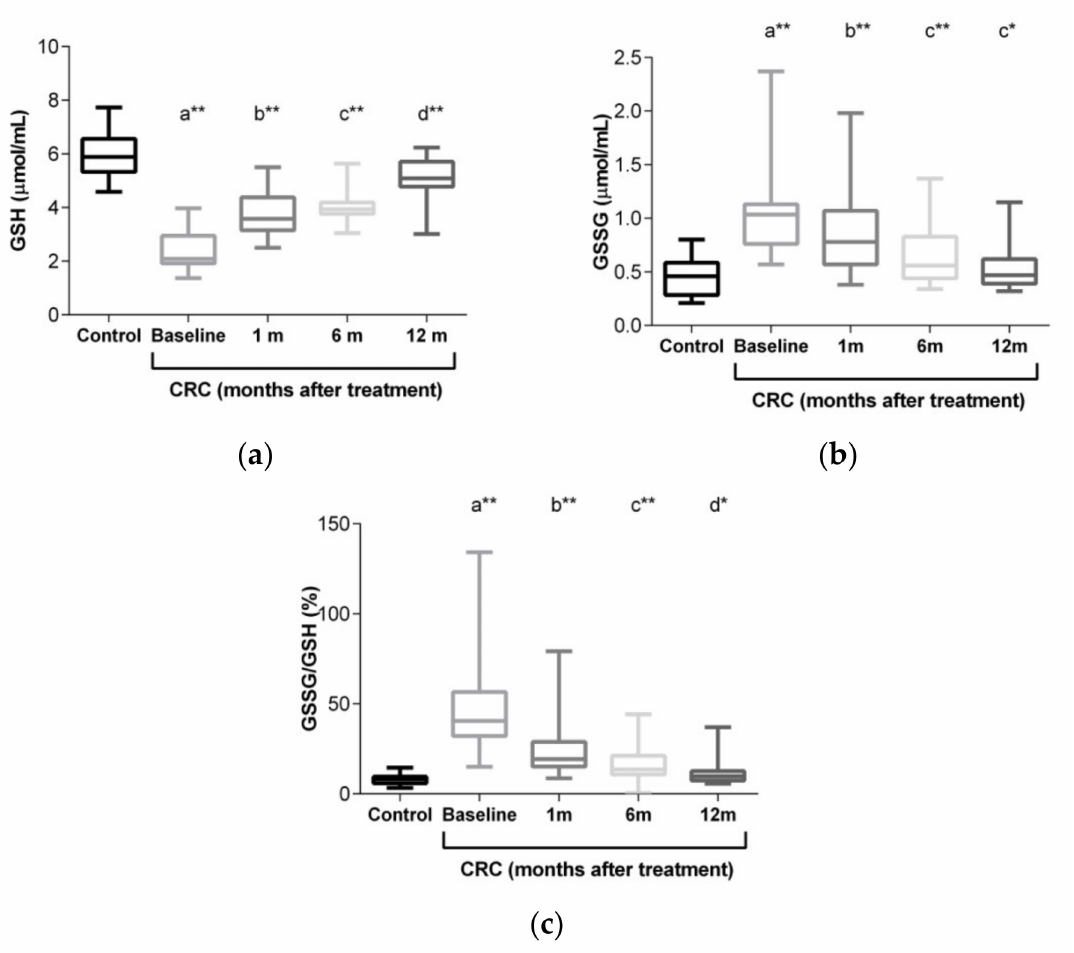
Figure 4. Time course evolution of serum glutathione levels after treatment of colorectal cancer (CRC) patients and controls. ( a ) Reduced glutathione (GSH); ( b ) oxidized glutathione (GSSG); ( c ) GSSG/GSH ratio. Data are expressed as box and whiskers. Values with different superscript letters ( a – d ) were significantly different when the evolutionary times of the CRC group were compared by repeated measures one-way ANOVA followed by a Student–Newman–Keuls post hoc test. * p < 0.05; ** p < 0.01 when control and CRC groups were compared with an unpaired Student’s t test. Table 3. Diagnostic tests of serum tumor markers (CEA and CA 19.9) and glutathione levels.